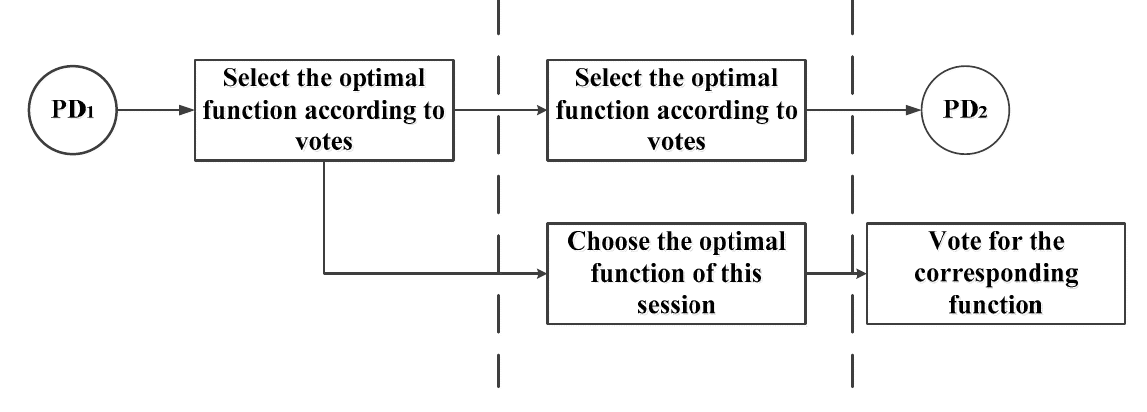
Figure 3. Dynamic voting process.